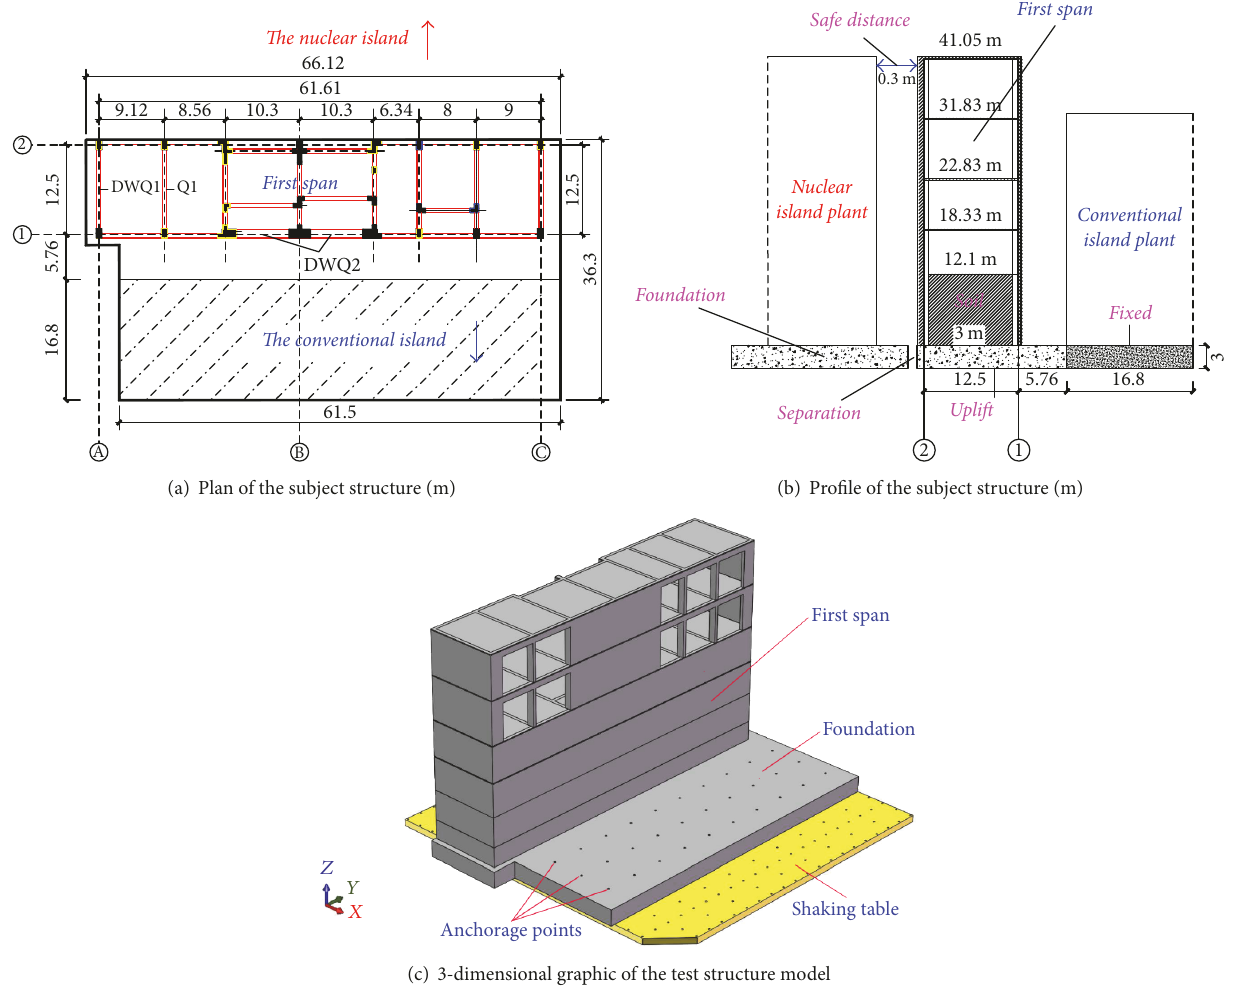
Figure 1: First span subject structure